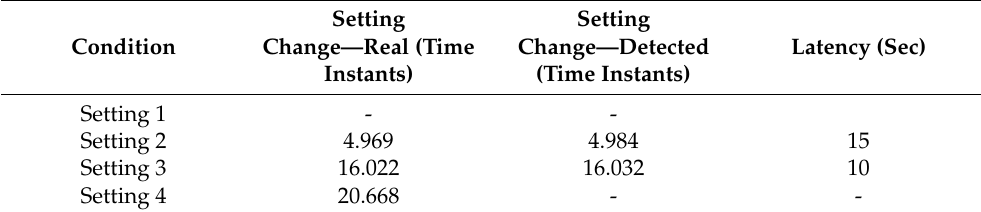
Table 4. Results of the streaming OCR.